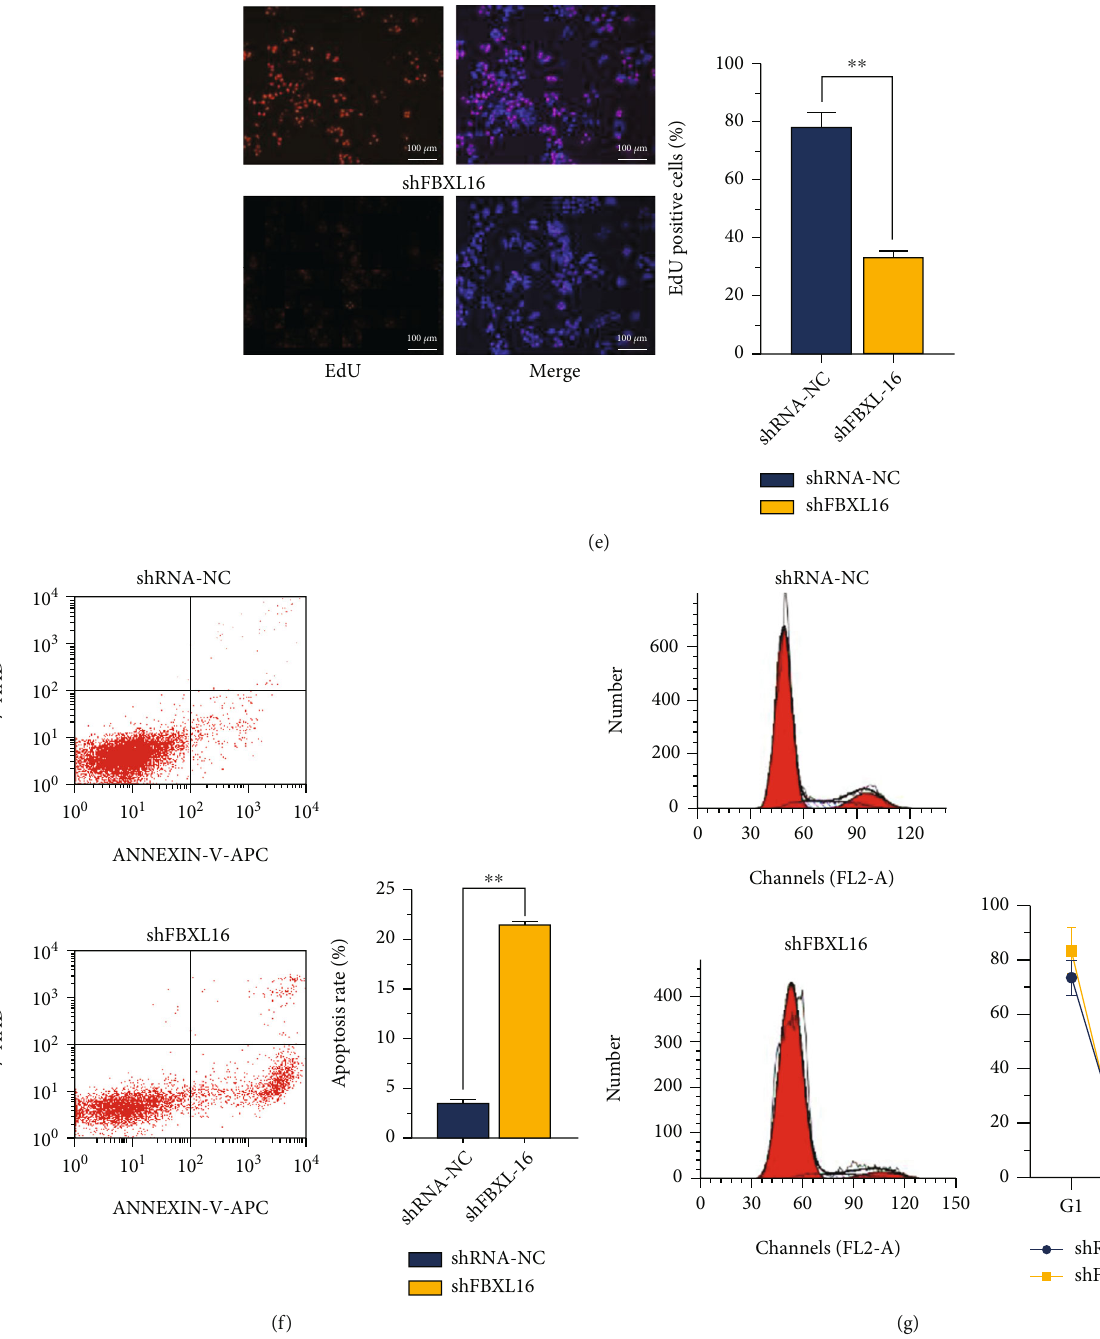
Figure 2: FBXL16 knockdown inhibited cell proliferation and MPA resistance of Ishikawa. (a) RT-qPCR examined the expression of FBXL16 in endometrial cancer cell lines in comparison with human immortalized endometrial epithelial cells (EEC-1). (b) RNA level of FBXL16 validated by RT-qPCR in parent Ishikawa cells (Ishikawa/P) and Ishikawa cells resistant to MPA (Ishikawa/MPA). (c) Transfection e ffi ciency of shFBXL16 in transfected Ishikawa/MPA cells by RT-qPCR. (d) Colony formation assay of Ishikawa/MPA with the shRNA-NC group or shFBXL16 group. (e) EdU incorporation assay of Ishikawa/MPA with the shRNA-NC group or shFBXL16 group. (f) Apoptosis detection of Ishikawa/MPA with the shRNA-NC group or shFBXL16 group by Annexin V-APC/7-AAD method. (g) DNA content detection of Ishikawa/MPA with the shRNA-NC group or shFBXL16 group by PI staining. Results are presented as mean ± SD . ∗ P < 0 : 05 . ∗∗ P < 0 : 01 . ∗∗∗ P < 0 : 001